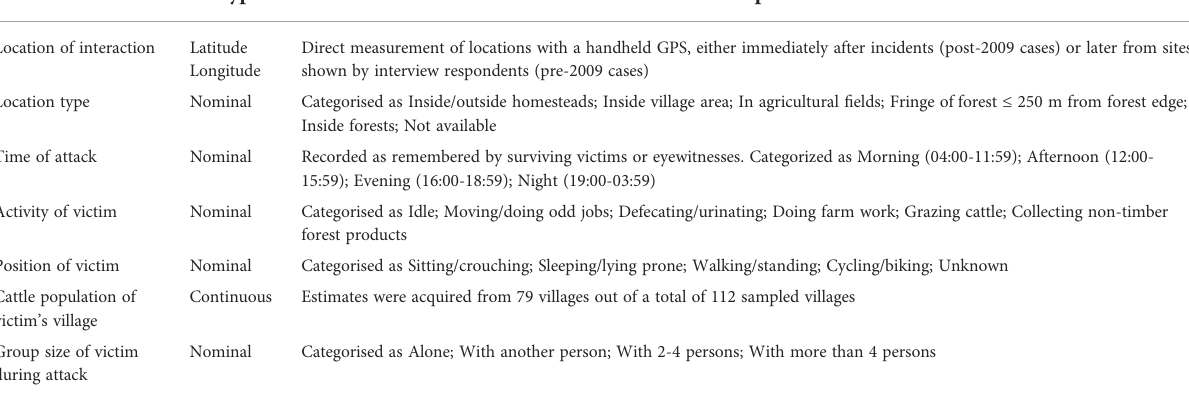
TABLE 1 Variables collected from con fl ict locations in this study.